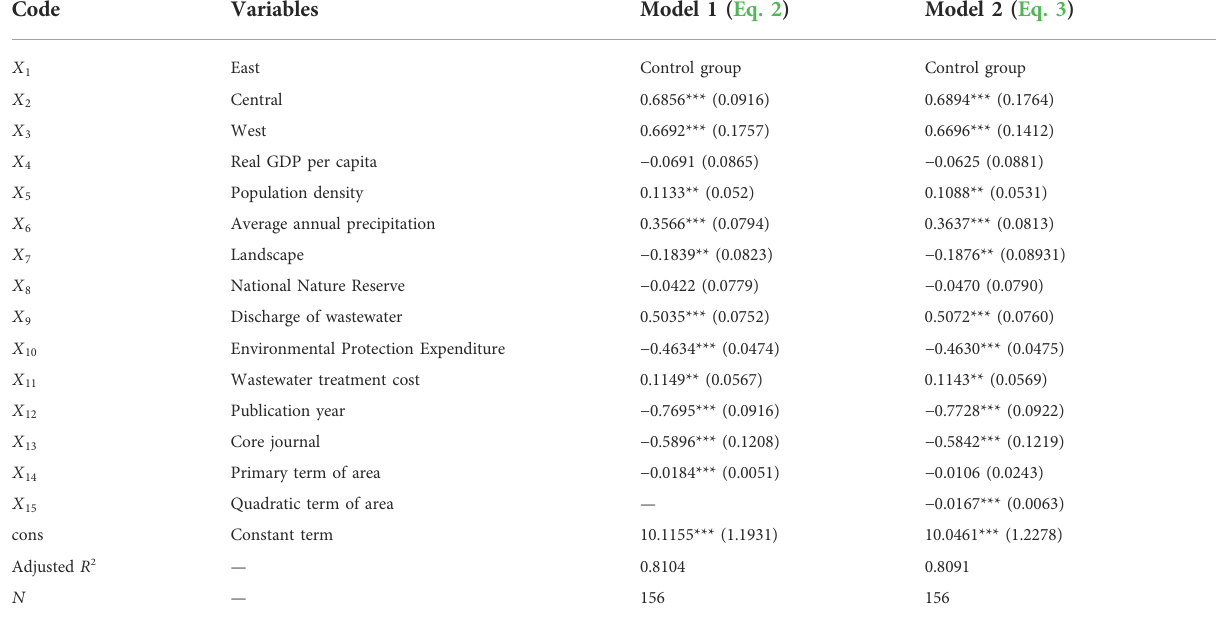
TABLE 3 Regression results of bene fi t transfer model in